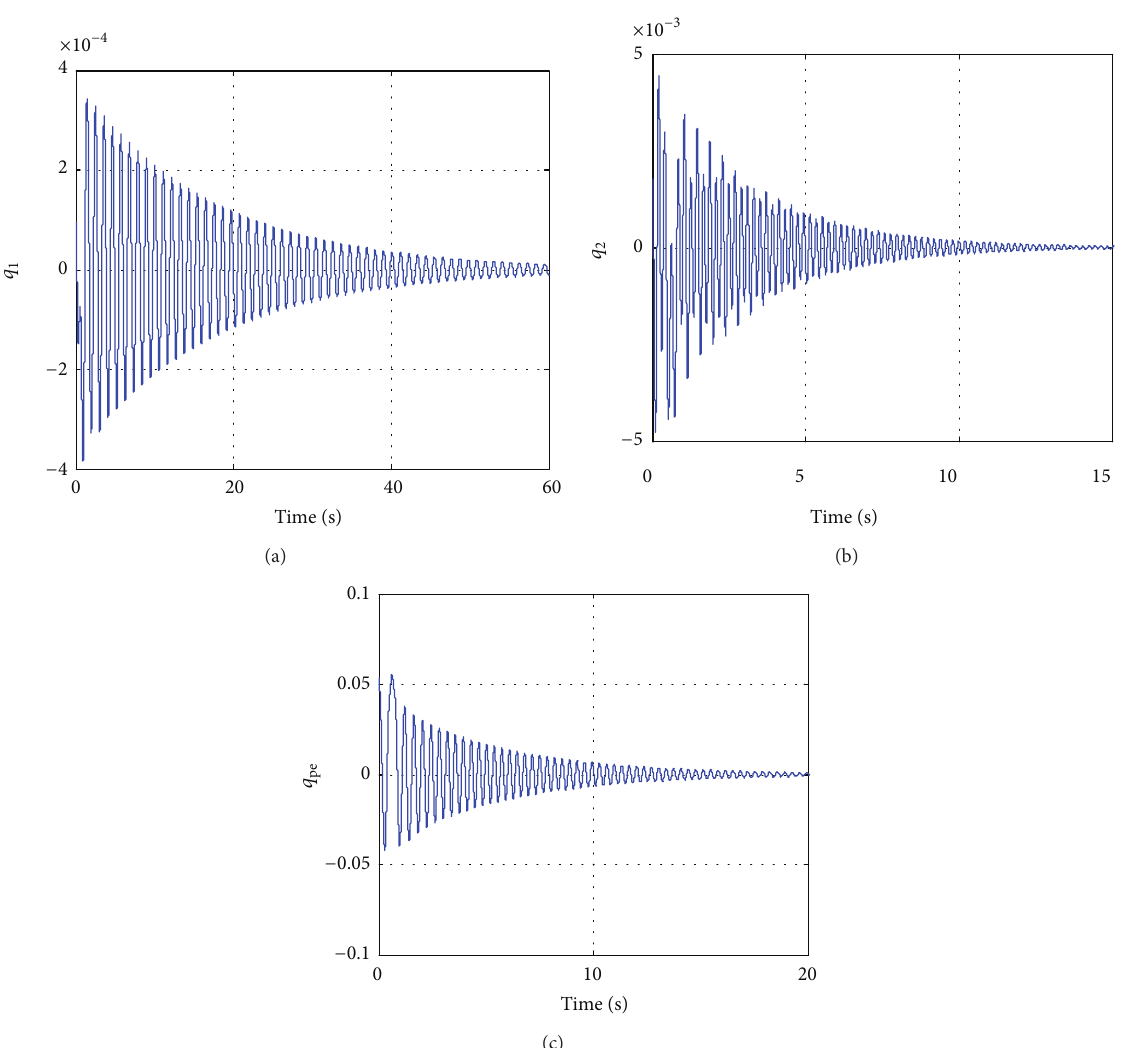
Figure 12: 3I3O system with adaptive feedback linearisation: response at 80ms −1